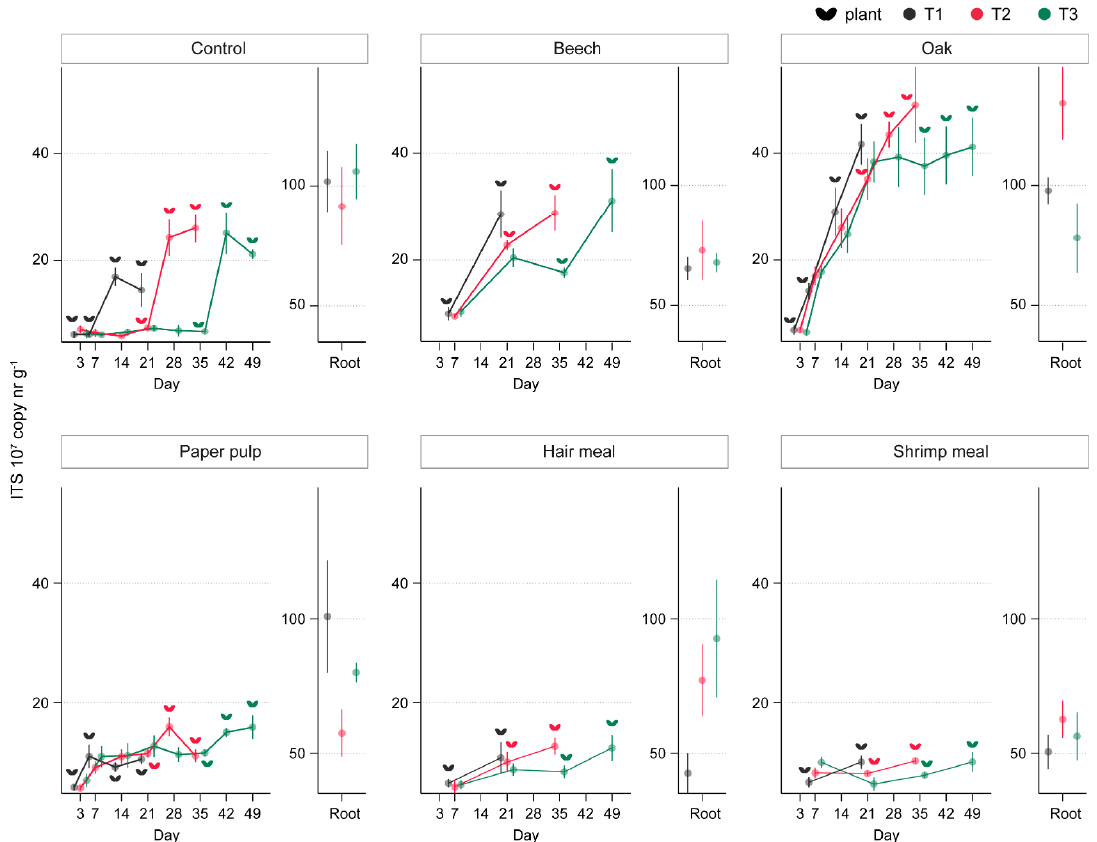
Figure 7. Quantification of fungal (ITS2) copy numbers in soil amended with five organic materials and sown at three time points after amendment. Fungal copy number was determined in soil of both planted and unplanted pots 1, 3, 7, 14, 21, 28, 35, 42, and 49 days after amendment ( x -axis) for control, oak, and paper pulp; whereas for beech, hair meal, and shrimp meal, data were collected for days 7, 21, 35, and 49 ( x -axis). For all soil treatments, fungal copy numbers in the roots are shown as mean ± se , n = 5. Plant symbols next to each data point indicate that soil samples were obtained from planted pots.